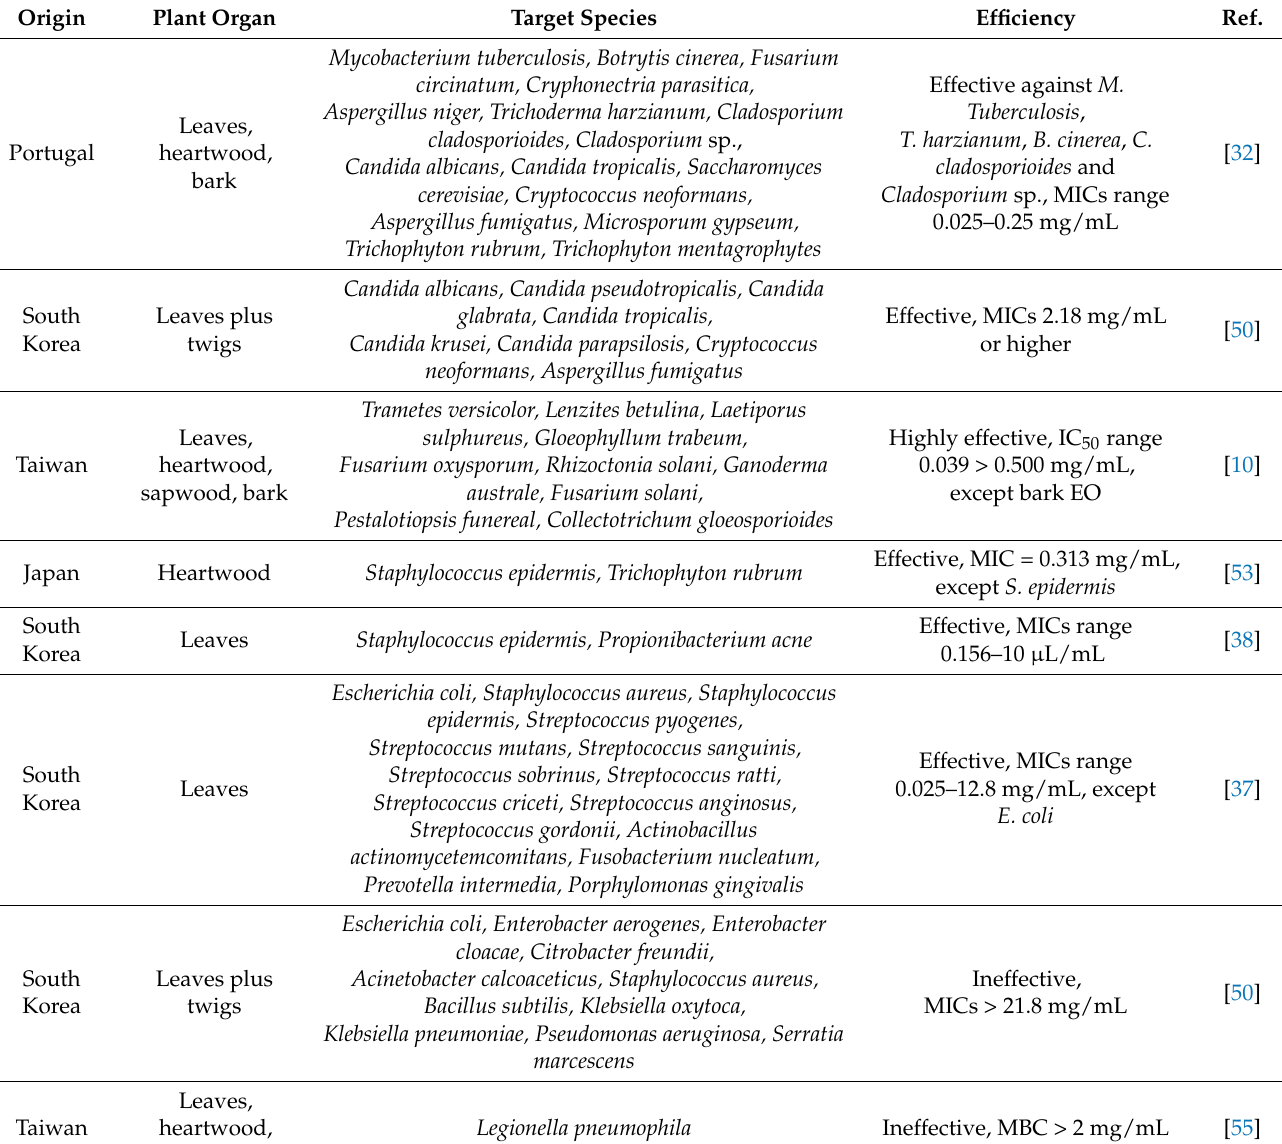
Table 3. Antimicrobial activities of Cryptomeria japonica essential oil by plant organ and country of origin.